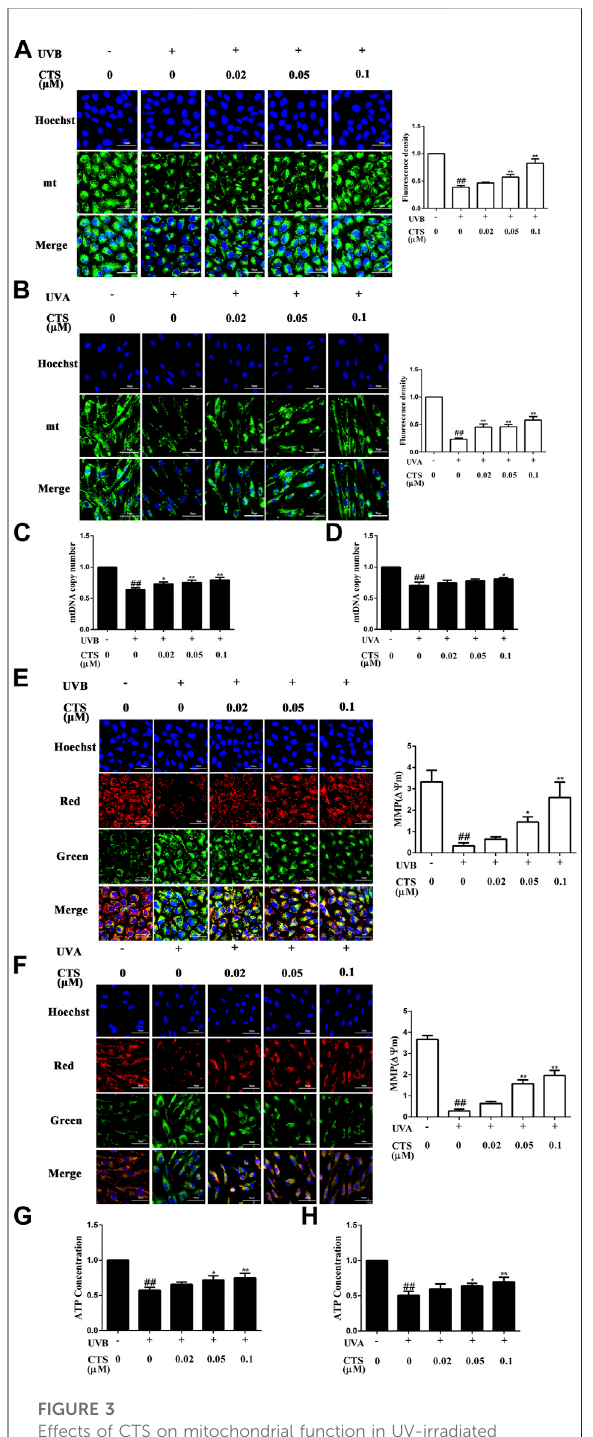
FIGURE 3 Effects of CTS on mitochondrial function in UV-irradiated HaCaT cells and HFF-1 cells. HaCaT cells and HFF-1 cells were treated with CTS (0, 0.02, 0.05, 0.1 μ M) for 4 h and then irradiated with UVB (200 mJ/cm 2 ) and UVA (15 J/cm 2 ), respectively. After UV irradiation, the cells were supplemented with the corresponding concentrations of CTS and incubated for the different times before analysis. (A) Fluorescence staining of Mito- Tracker Green probed HaCaT cells after 1-h of incubation following UVB irradiation. Scale bars: 50 μ m. The plot shows